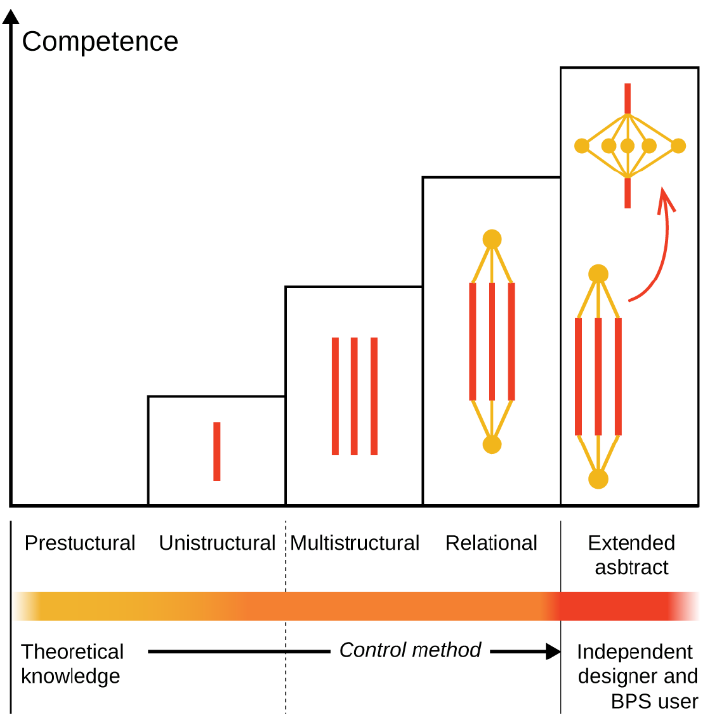
Figure 5. The control method in the framework of the SOLO taxonomy (Biggs and Collis, 1982) [30].